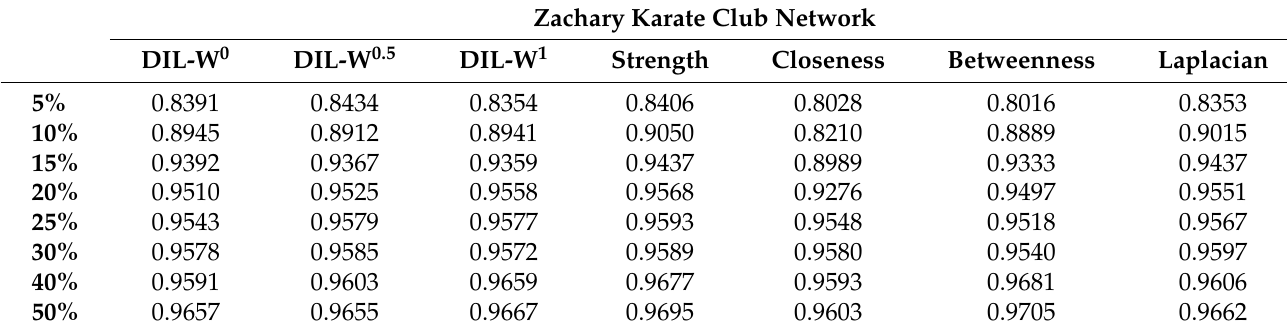
Table A1. σ according to different values of k in Zachary karate club Network. Zachary Karate Club Network